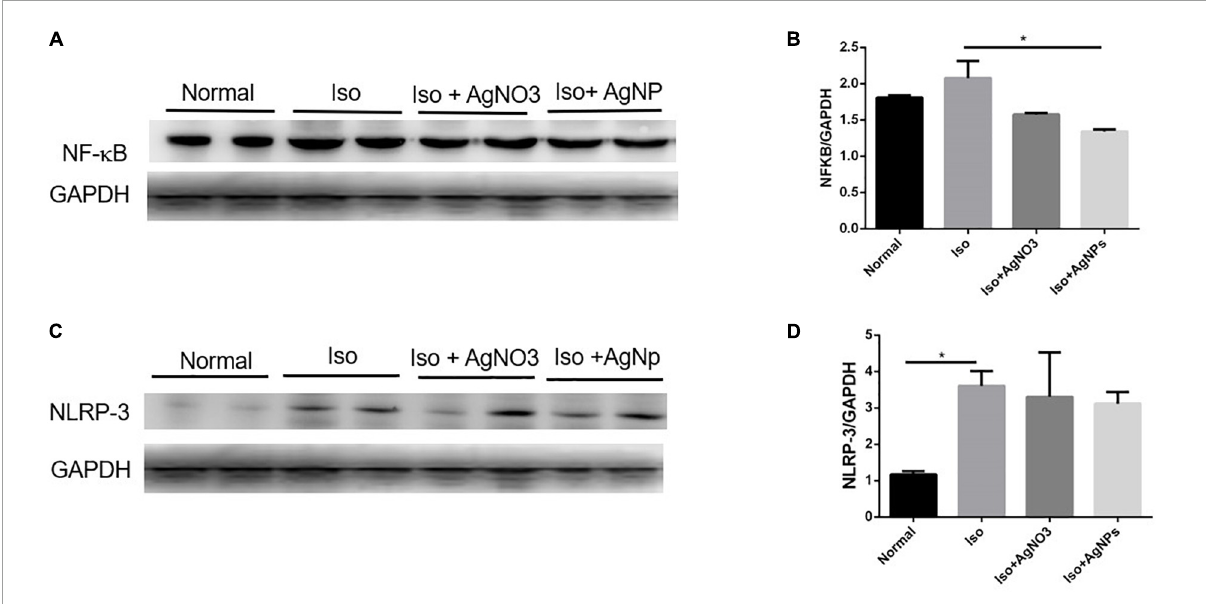
FIGURE8 Representative western blot gel in the cardiac tissue of GAPDH, NF- κ B, and NLRP3 (A,C) ; quantified band analysis of NF- κ B and NLRP3 protein expression (B,D) . The quantified result was normalized to GAPDH expression. Data analysis was performed using one-way ANOVA, followed by Tukey multiple comparison test. * P < 0.05. Iso, isoproterenol; AgNO 3 , silver ion; AgNPs, silver